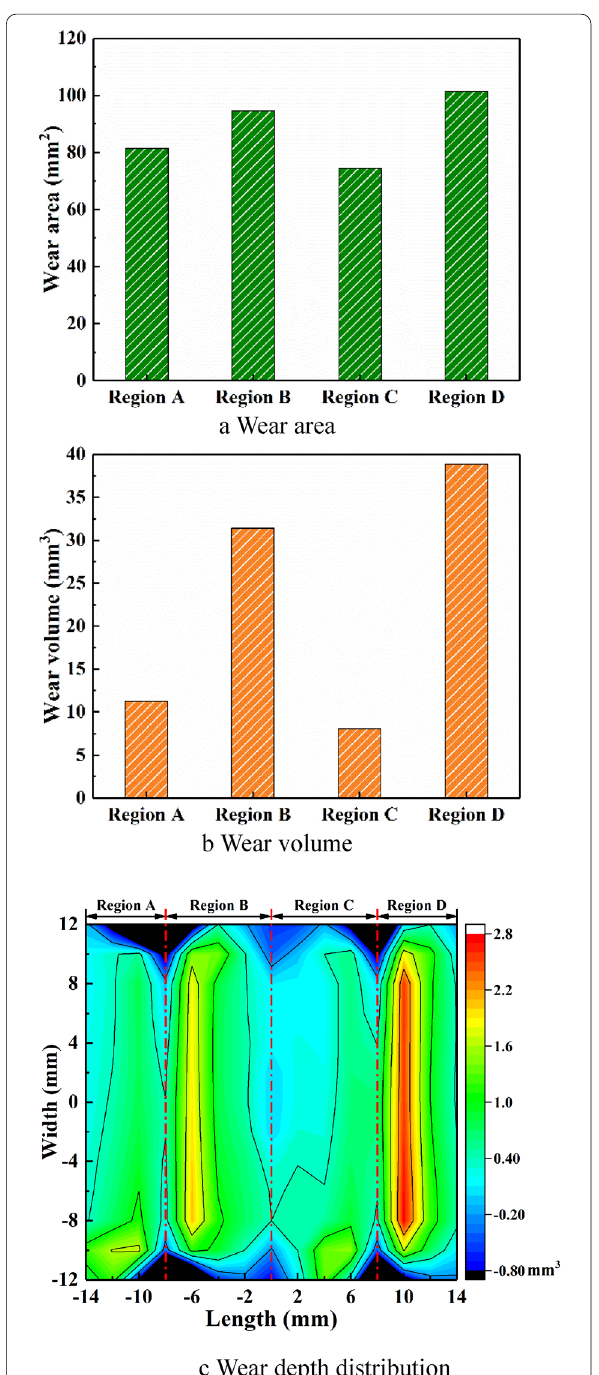
Figure 9 Wear results of movable latch on various claw surfaces